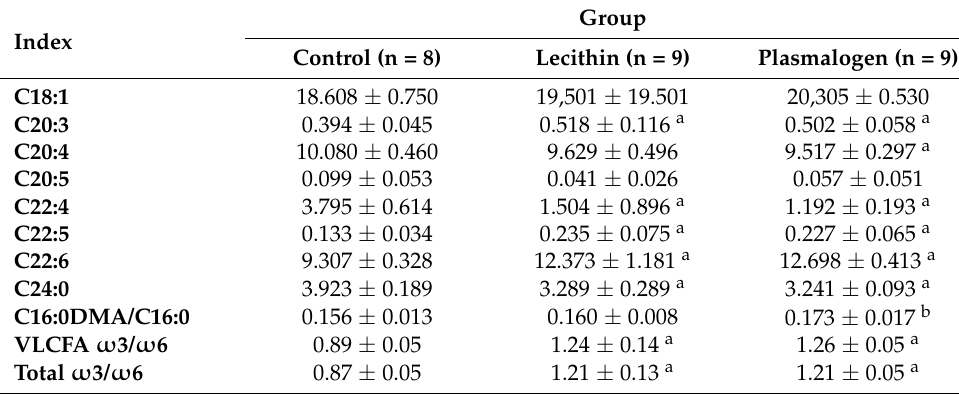
Table 3. Main fatty acids and fatty aldehydes composition of rat